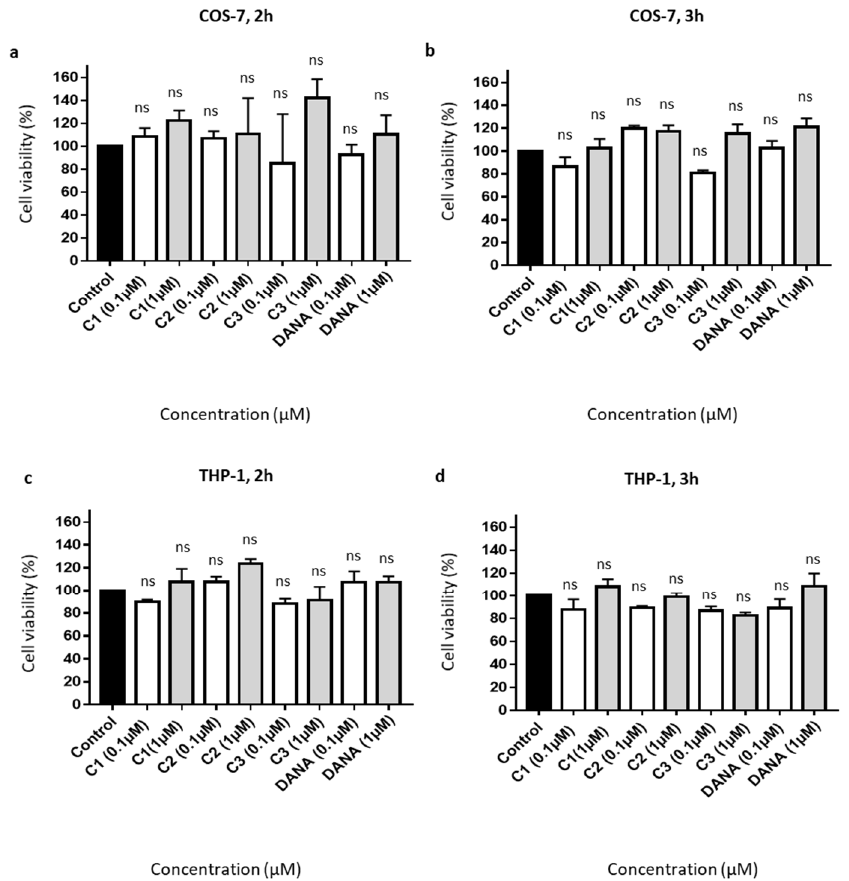
Figure 2. Effects of the vegetal compounds and of N-Acetyl-2,3-dehydro-2-deoxyneuraminic acid on cell viability. ( a – d ) 10,000 COS-7 and THP-1 cells were plated in 96 well plates. Cells were incubated with the natural compounds 1, 2, 3, or DANA at 0.1 or 1 µ M. ( a ) Effects on COS-7 cell viability after 2 h. ( b ) Effects on COS-7 cell viability after 3 h. ( c ) Effects on THP-1 cell viability after 2 h. ( d ) Effects on THP-1 cell viability after 3 h. Results were normalized to the control condition expressed at 100%. ( n = 3–4), (ANOVA). Each run in triplicates, (C1: feddeiketone B, C2: 2,3-Dihydroxy-1-(4-hydroxy-3,5-dimethoxyphenyl)-1-propanone, C3: syringylglycerol, DANA: N-Acetyl-2,3-dehydro-2-deoxyneuraminic acid), (ns: non-significant). 3.3. Effects of Selected Compounds 1 – 3 on Sialidase Activity in COS-7 Cells Overexpressing